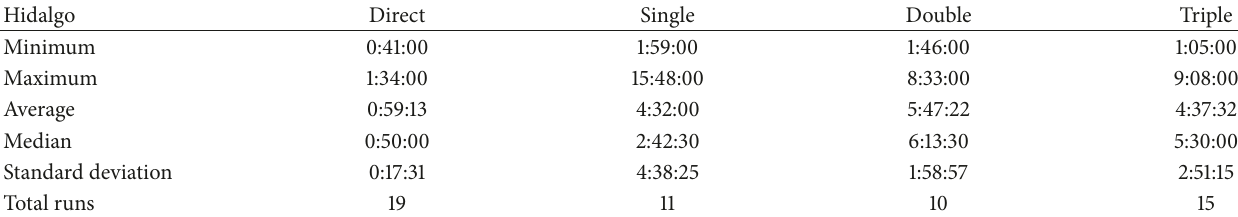
Table 4: Convergence times for various simulation types for trajectories to